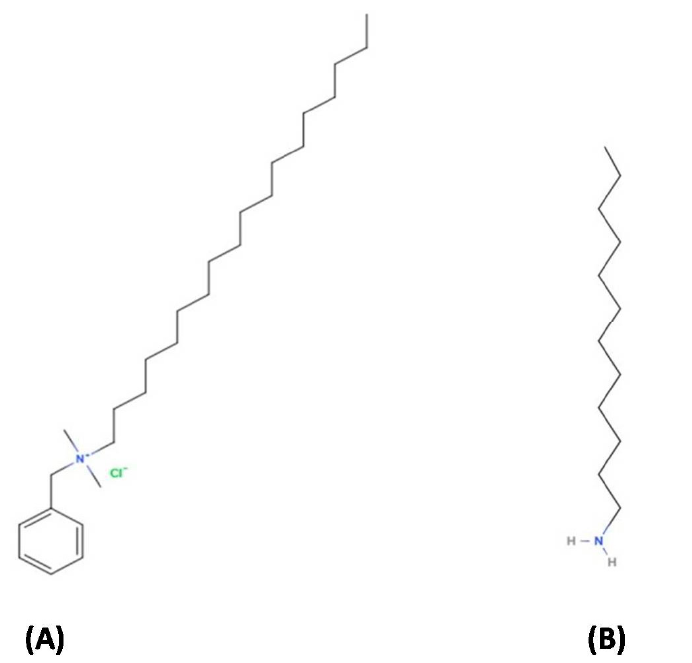
Figure 7. The structural formula of ( A ) octadecyldimethylbenzylammonium chloride (O) and ( B ) dodecylamine (D).